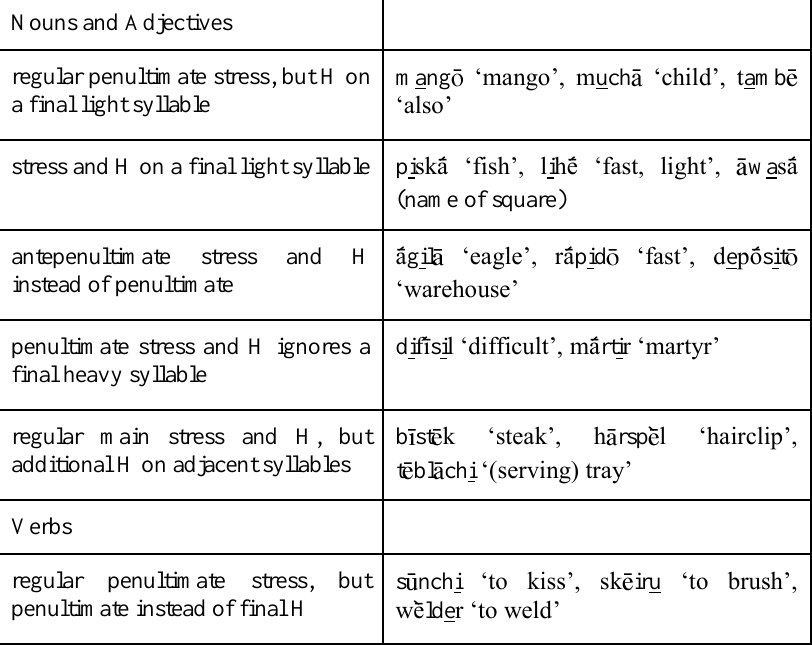
Table 2. Irregular tone and stress placement Nouns and Adjectives regular penultimate stress, but H